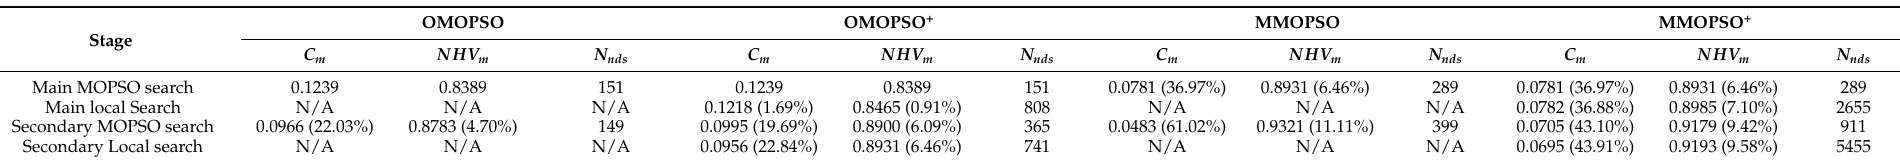
Table 4. Values of C m , NHV m , and N nds for the final PFs in BIN (relative improvements in C m and NHV m with respect to the main MOPSO search stage of OMOPSO are in